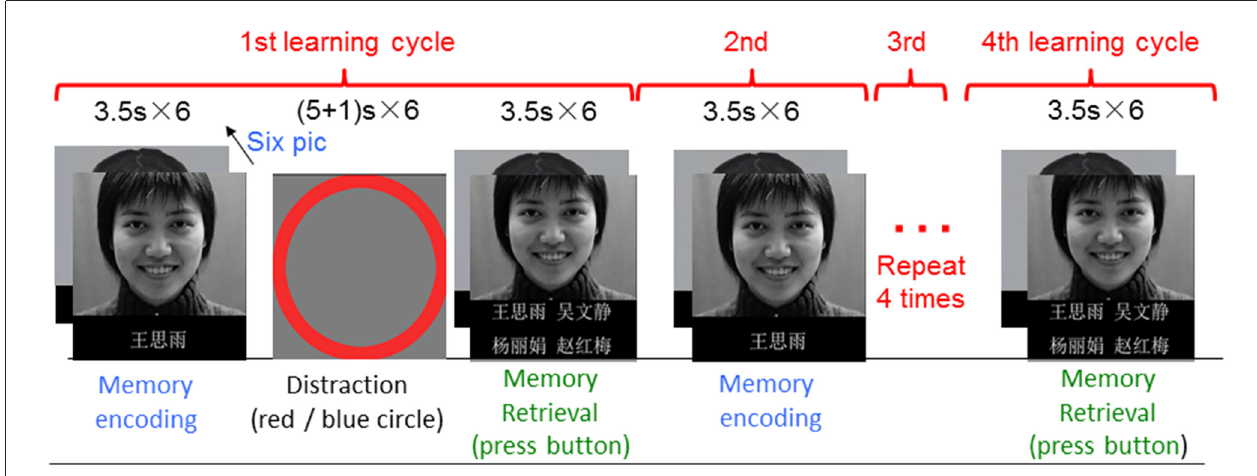
FIGURE 1 | Illustration of the fMRI task. The task was modified from Zeineh’s article (Zeineh et al., 2003). The pictures were taken from the Chinese Facial Affective Picture System (Gong et al., 2011).